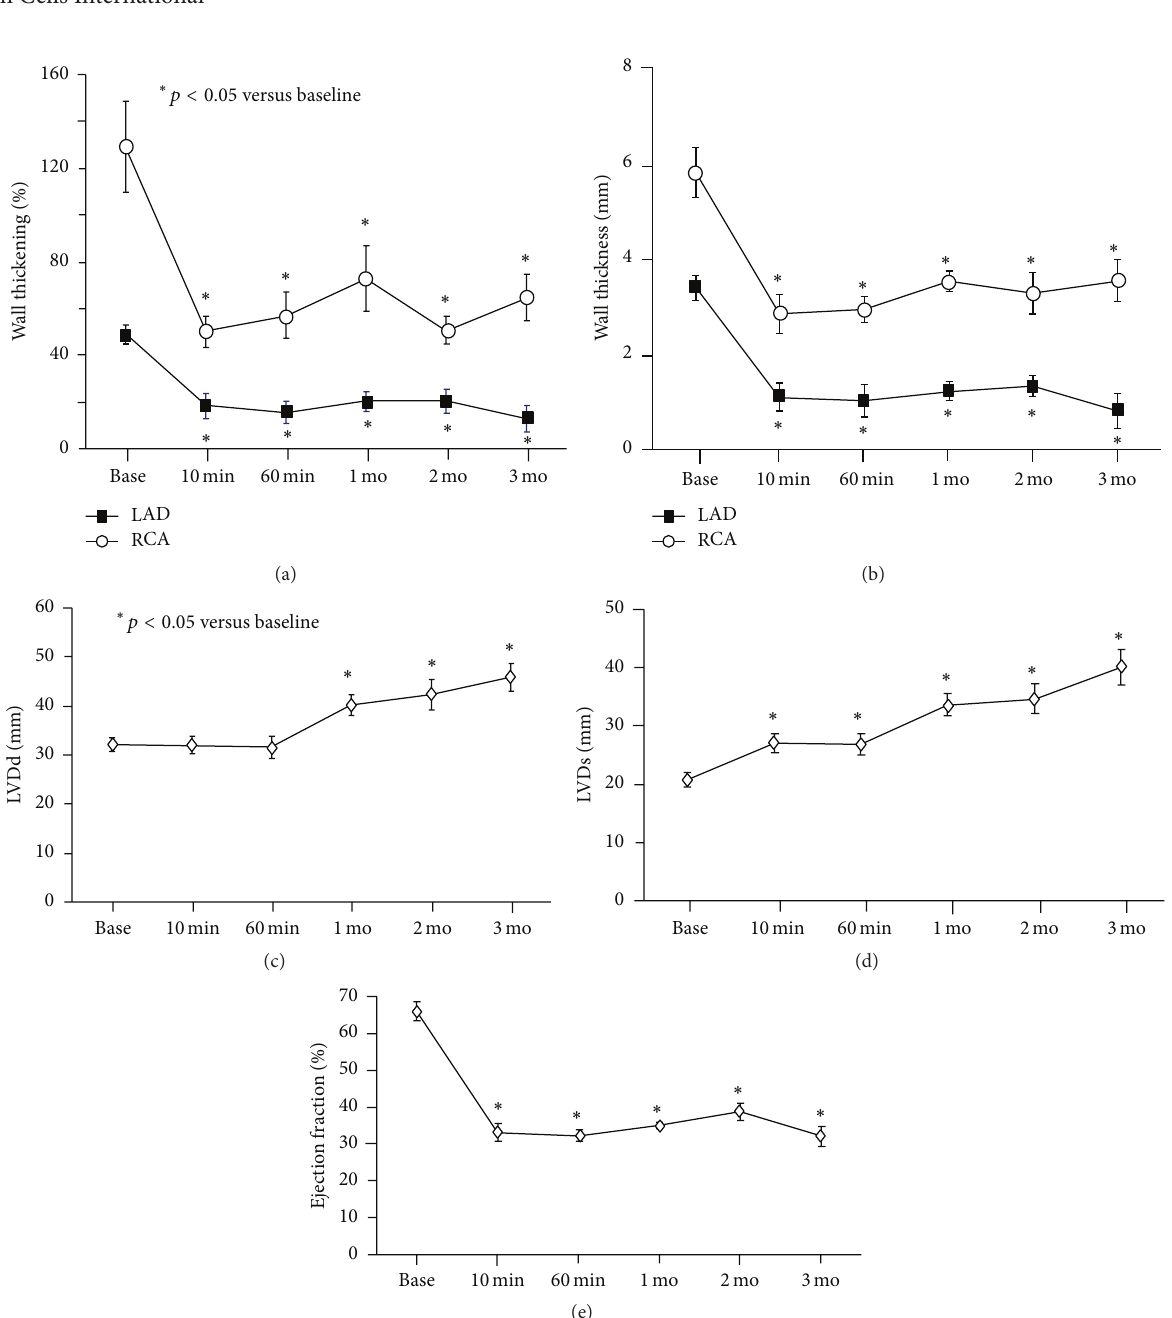
Figure 2: Regional and global function after microembolization. Regional and global function were severely depressed and remained constant until 3 months. The temporal changes of wall thickening (%) and Δ wall thickness (mm) in the LAD and normal remote regions are summarized in (a) and (b). As early as 10 minutes after microembolization, regional wall thickening in LAD and remote regions was significantly reduced and remained constant until 3 months. Although LV end-diastolic and end-systolic dimensions slowly increased, global function remained depressed until 3 months ((c), (d), and (e)). LVDd: left ventricular distance diastole. LVDs: left ventricular distance